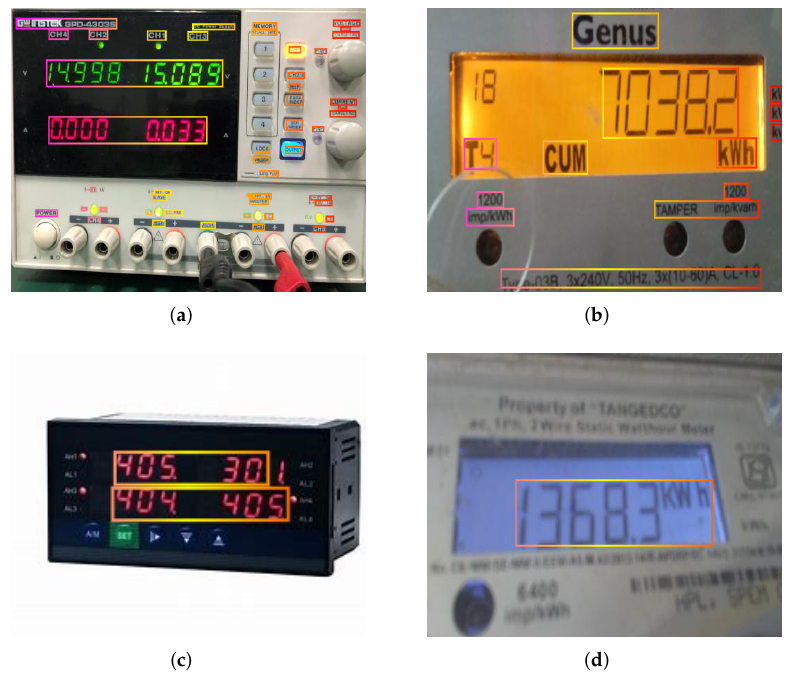
Figure 11. Part result of testing. ( a ) sample1, ( b ) sample2, ( c ) sample3, ( d ) sample4.